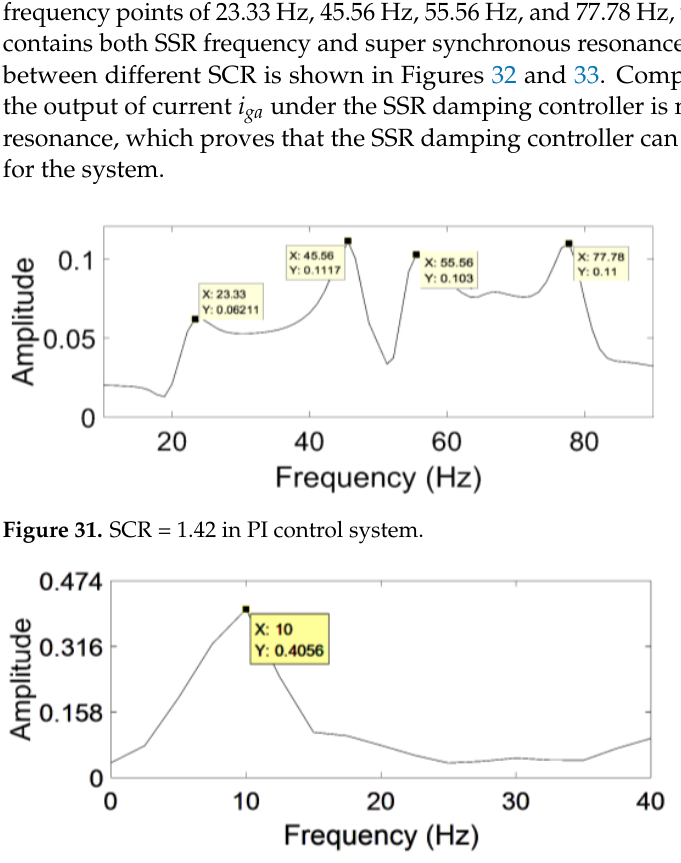
Figure 32. SCR = 1.16 in PI control system.